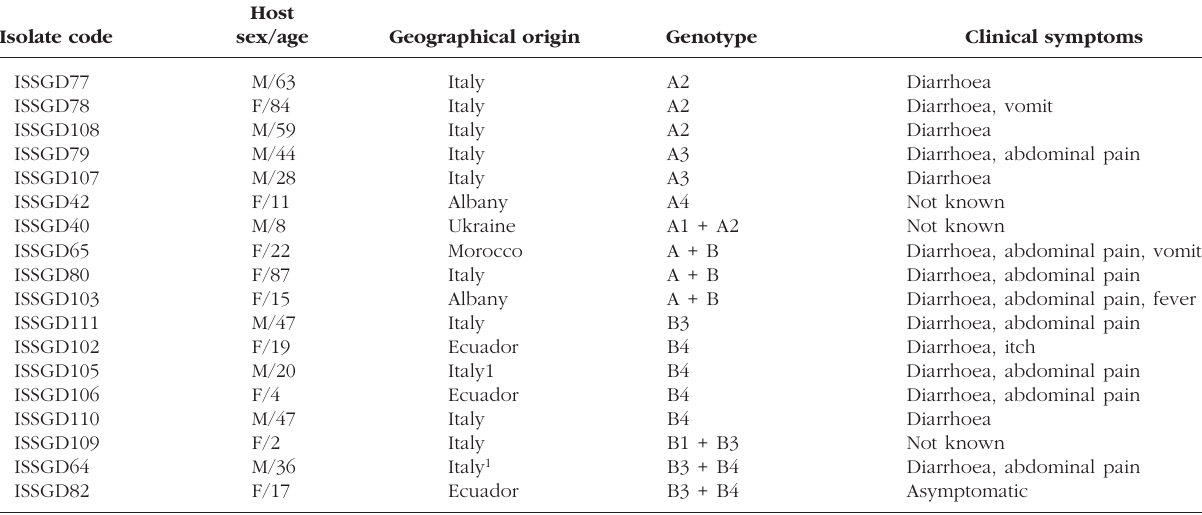
Table II. – Assemblage and genotype of 18 isolates of Giardia duodenalis collected at the day care centre of Perugia, Italy, from 2002 to